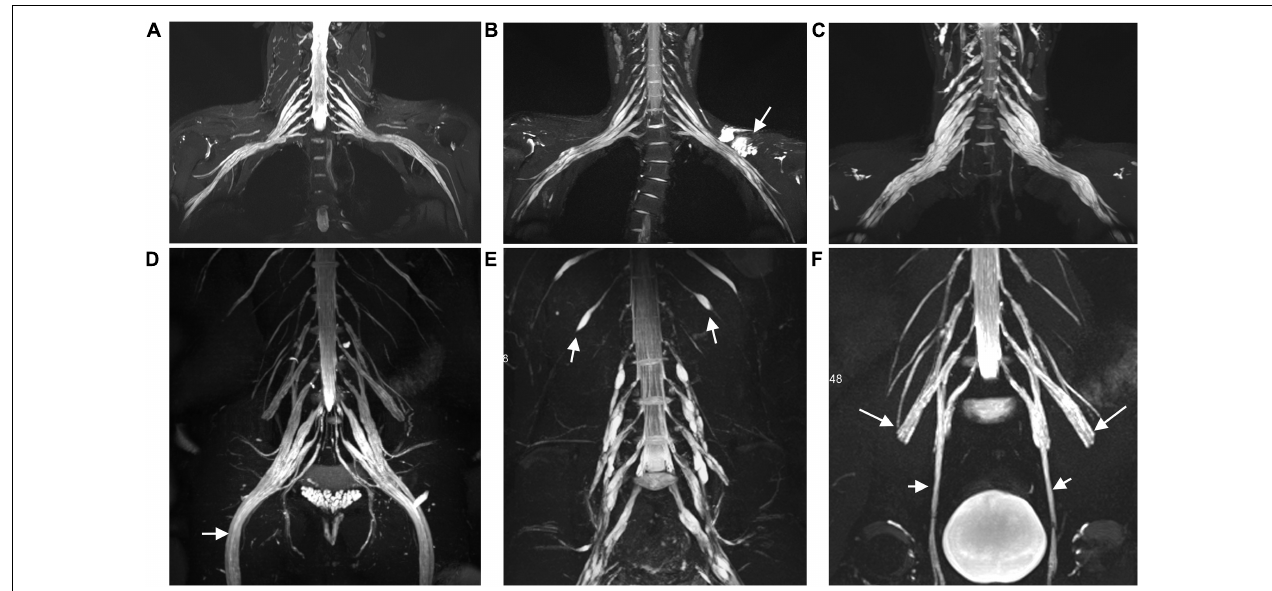
FIGURE 1 | Representative coronal MIP images (SPACE) show diffuse uniform and multifocal fusiform hypertrophy of the brachial (A–C) and lumbosacral (D–F) plexus in patients with CIDP. The sciatic (arrow in D ), intercostal (arrow in E ), femoral (long arrows in F ), and obturator nerve (arrows in F ) involvements present diffuse symmetrical hypertrophy. A patient with a 7-year disease course showing uniform thickening in the brachial plexus (B) , but multifocal fusiform hypertrophy in the lumbosacral plexus (E) . The lesion with a long T2 signal on the left side represents a subcutaneous hemangioma (arrow in B ). Image (C) shows multifocal fusiform hypertrophy with striking increased T2 signal intensity in the brachial plexus.